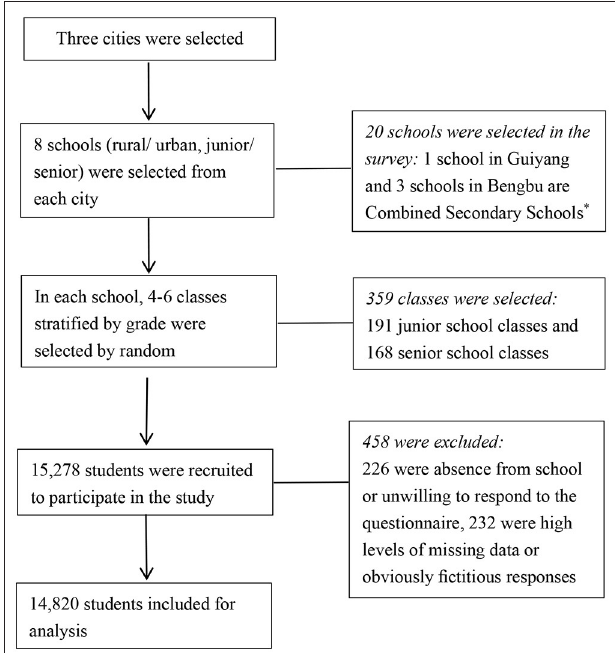
FIGURE 1 | The flow diagram presenting the selection of study participants. * Combined Secondary School refers to a school with both a junior school and a senior